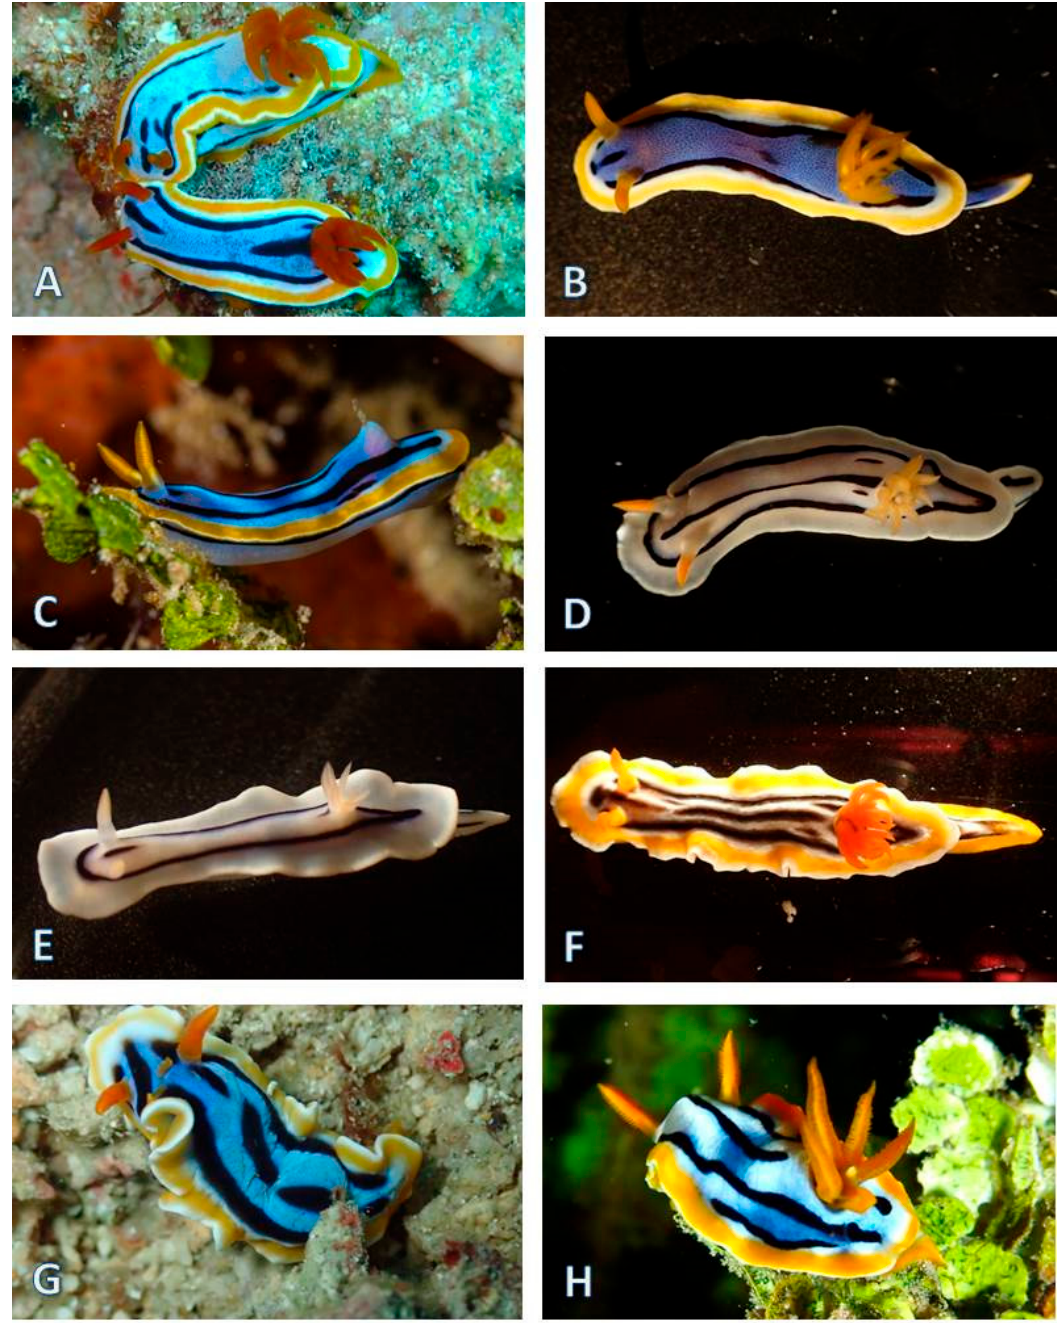
Figure 11. Nudibranchia Doridina: ( A , B ) Chromodoris annae , Chan18Ba-11-12, Chan18Ba-7; ( C ) Chromodoris elisabethina* ; ( D , E ) Chromodoris lochi , Chlo18Ba-6, Chlo18Ba-1; ( F ) Chromodoris magnifica , Chma18Ba-1 ; ( G ) Chromodoris quadricolor, Chma18a-2; ( H ) Chromodoris strigata, Chst17Ba-1. *Specimen not collected.